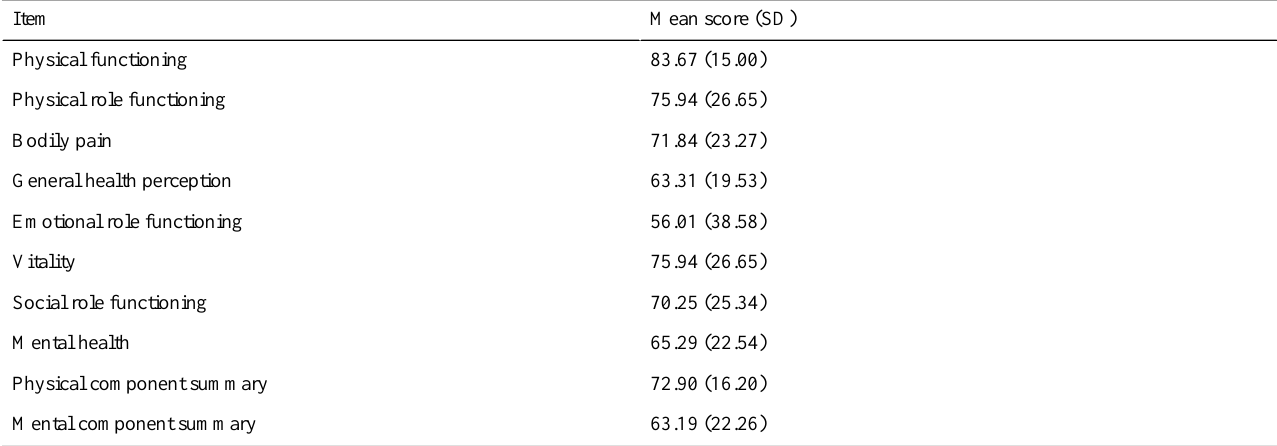
Table 3. SF-36 scores of the students.